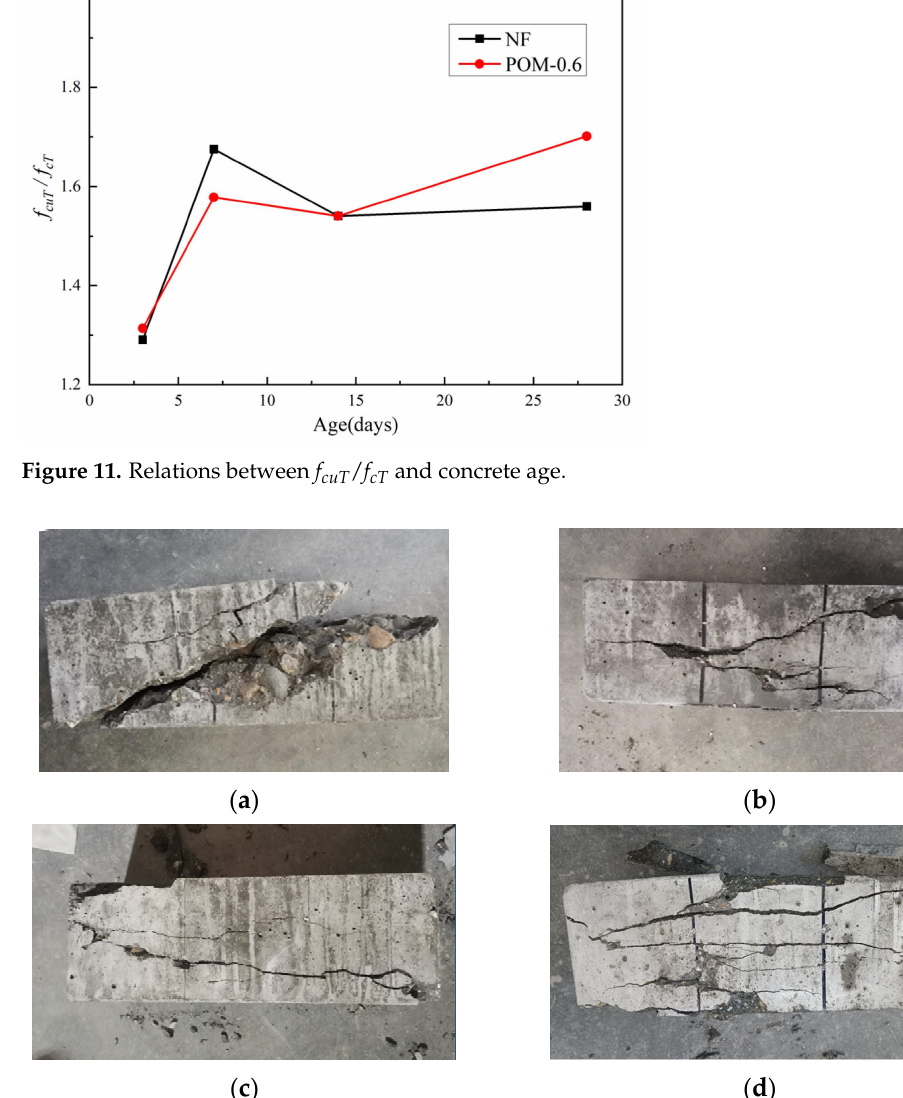
Figure 12. Failure performance of NF specimens with different ages after axial compressive